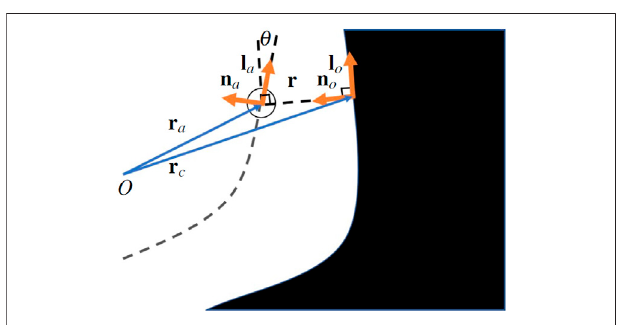
FIGURE 4 | The scenario of a robot moving in the vicinity of a concave obstacle which has a continuous